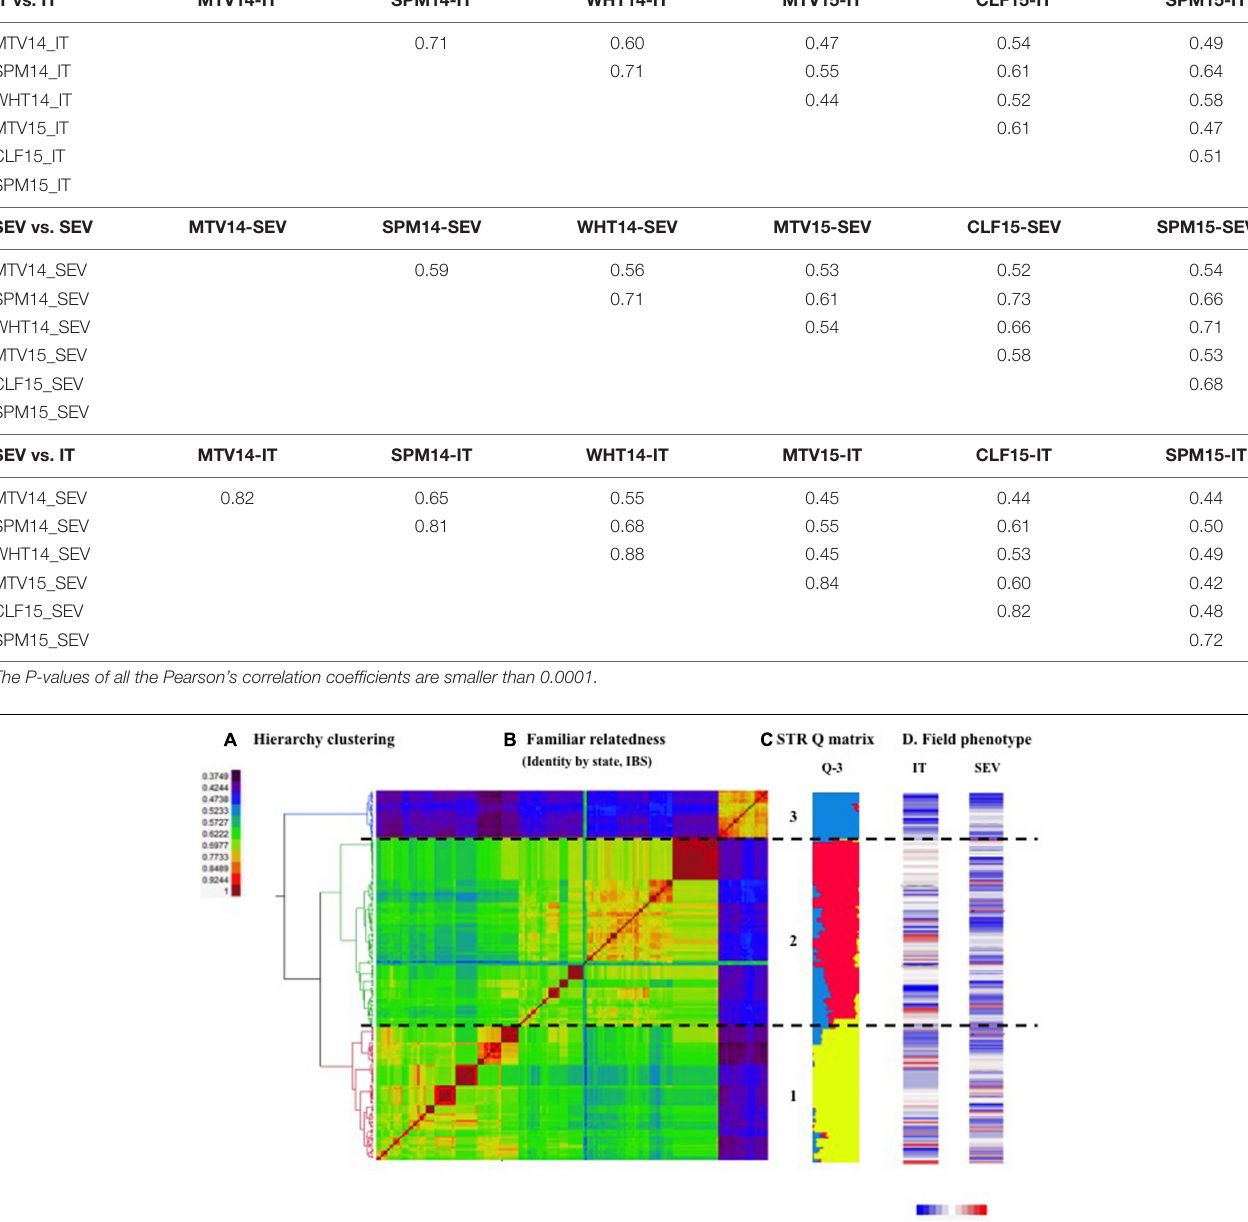
B genome had 54% significant marker pairs and an average r 2 of 0.108. Chromosomes 1A (63%) and 5A (61%) had the highest percentage of significant marker pairs of LD r 2